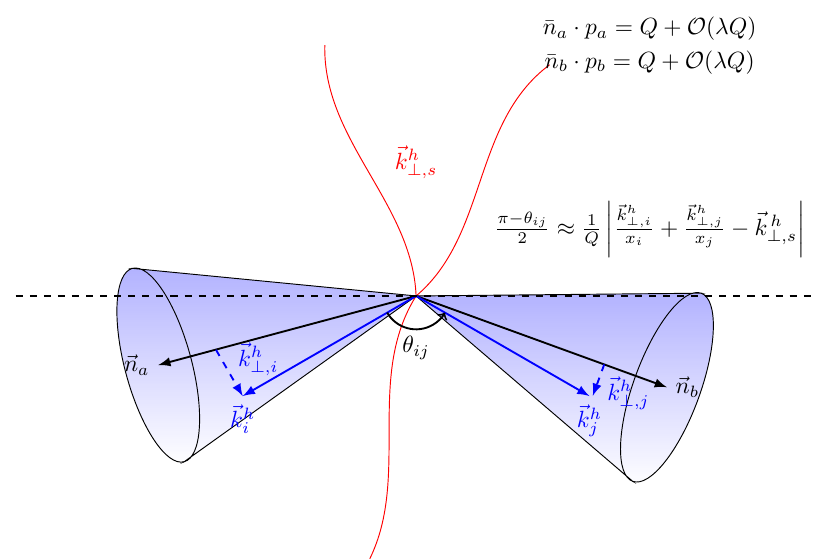
Figure 2. A schematic of the kinematics relevant for the description of the EEC observable in the back-to-back limit, z 1. The total transverse momentum of (cid:12)nal-state hadrons perpendicular ! to the thrust axis (the black dashed line) is denoted as ~k h collinear hadrons which enter weighted sum in eq. (2.2) are denoted as ~k h transverse components perpendicular to the jet axis ~n a;b are ~k h only to recoil the two collinear sectors, denoted by ~n a;b , with respect to each other, but does not contribute directly to the